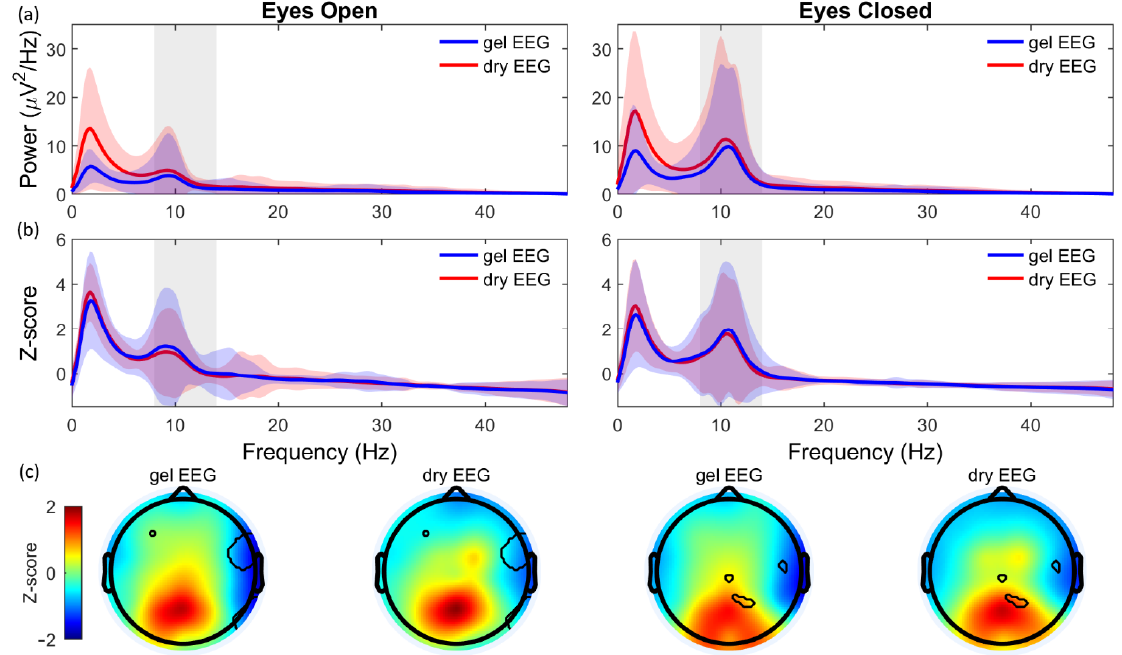
Figure 4. Power spectral density (PSD) of the 40 Hz Auditory steady-state response (ASSR) for the gel EEG system (blue; left) and dry EEG system (red; right). ( a ) Absolute PSD of the 40 Hz-ASSR ( μ V 2 /Hz), averaged over channels per subject. ( b ) Standardized PSD of the 40 Hz-ASSR (Z-score), averaged over channels per subject. Black lines indicate average PSD over all subjects and channels; shaded areas indicate the confidence interval (mean ± 2xSD).